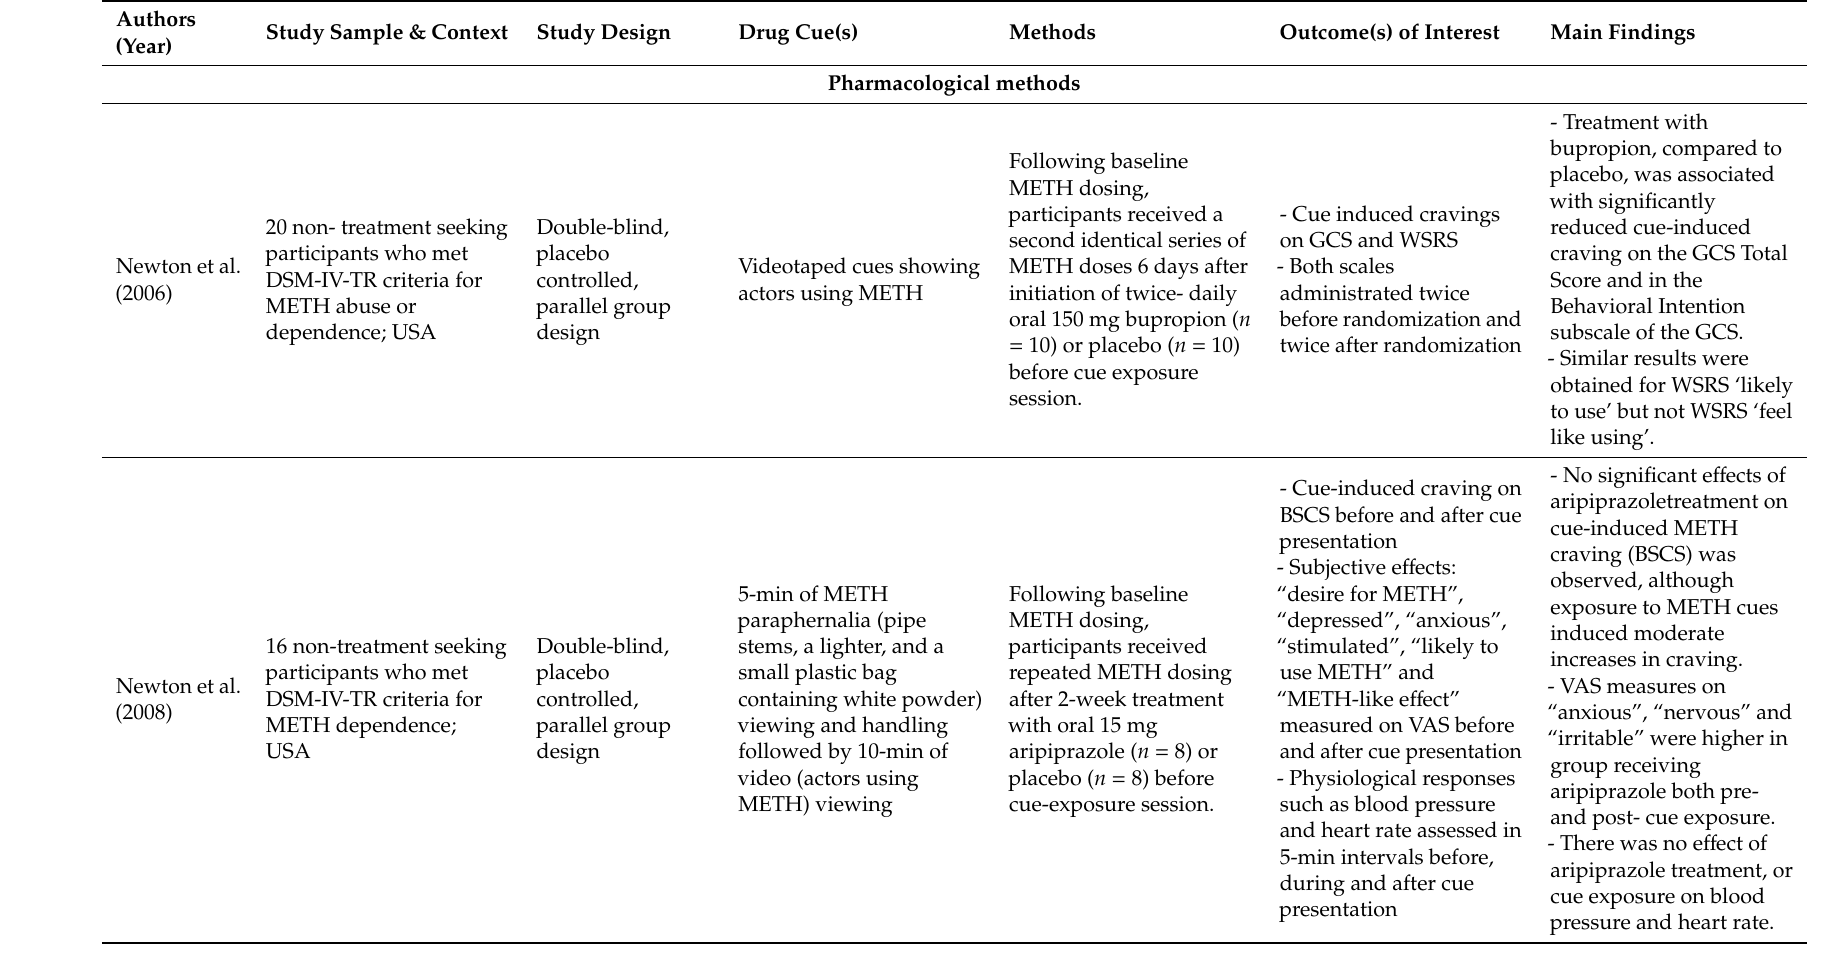
Table 2. Details of included studies that looked at methods that modulate cue-elicited cravings and reactivity or involve cue